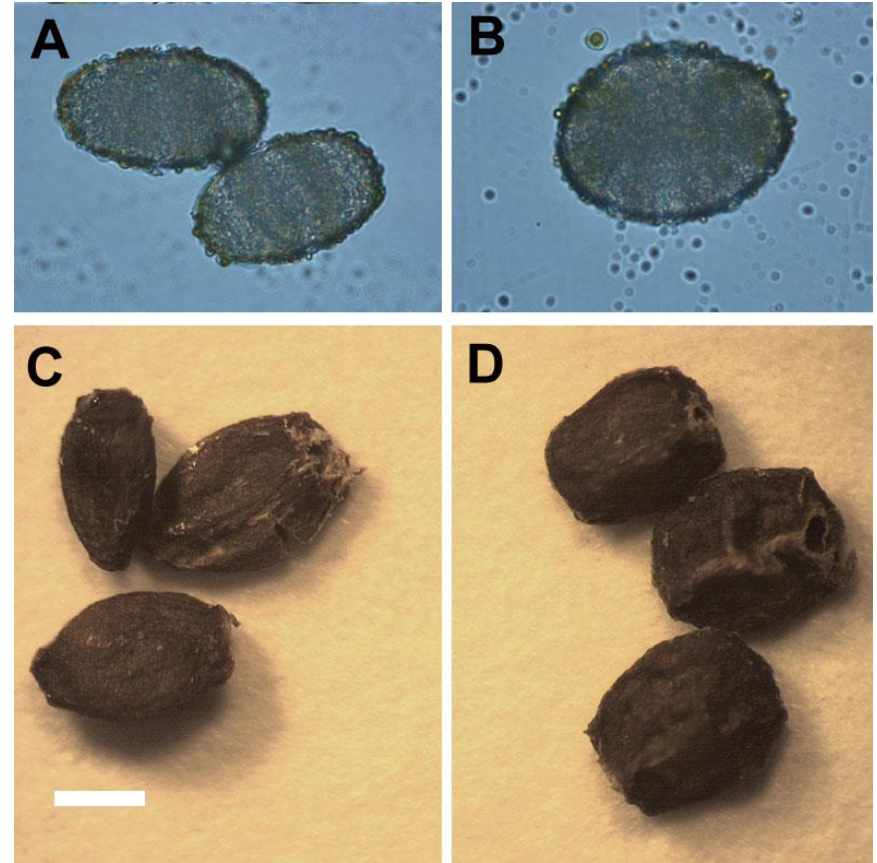
Figure 6. Pollens and seeds of 2 x and 4 x plants in Salvia miltiorrhiza (bar = 15 μm for all figures). ( A